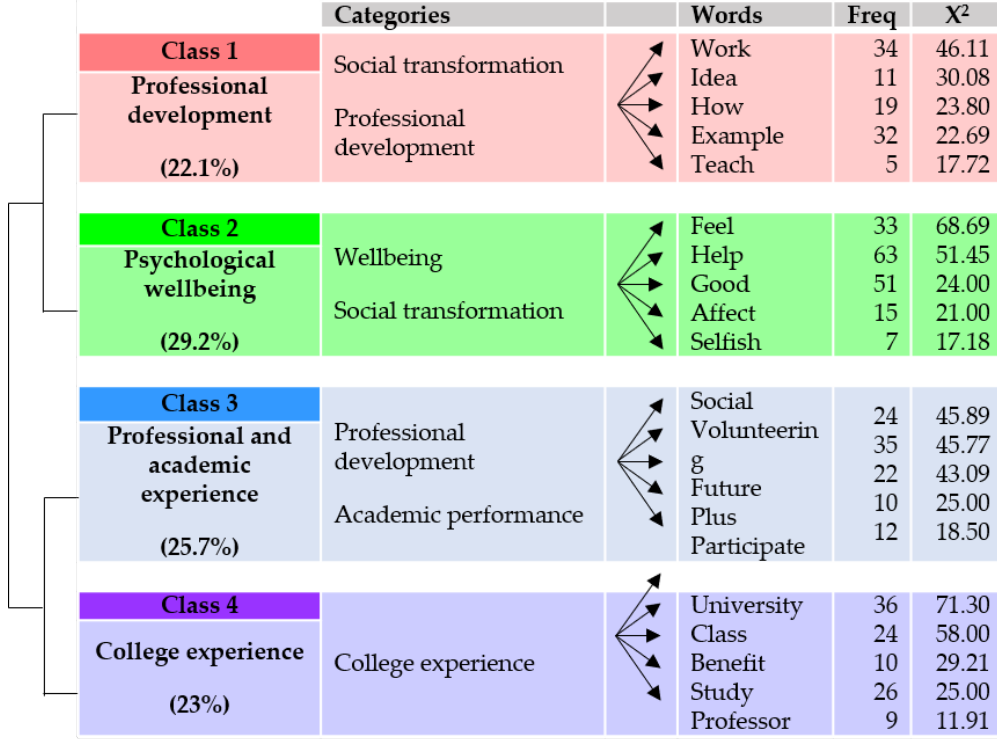
Figure 4. Distribution of classes and their respective units of meaning (preinterviews).